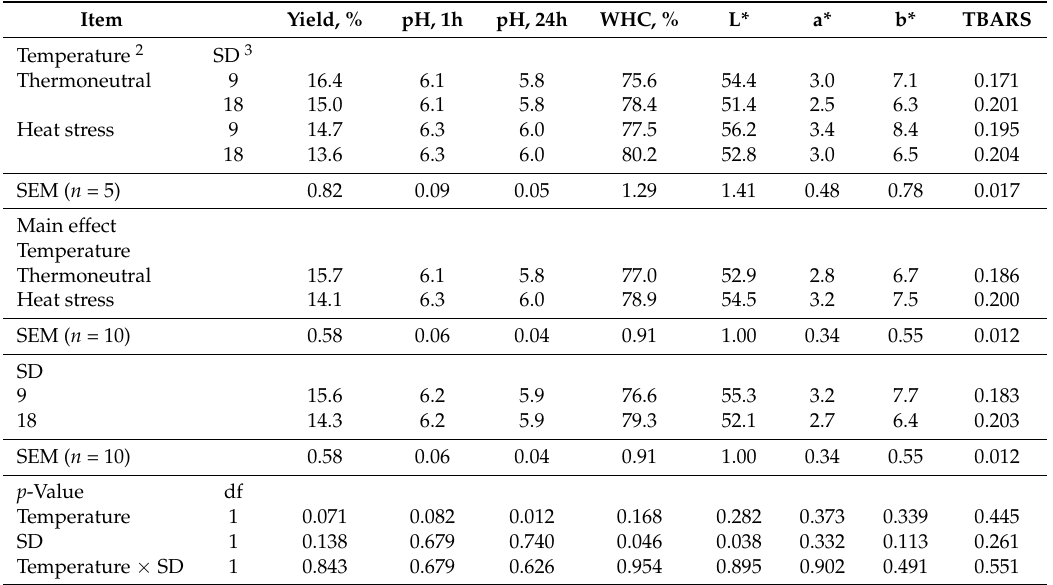
Table 3. Effect of heat stress and stocking density on the breast meat quality of growing broiler